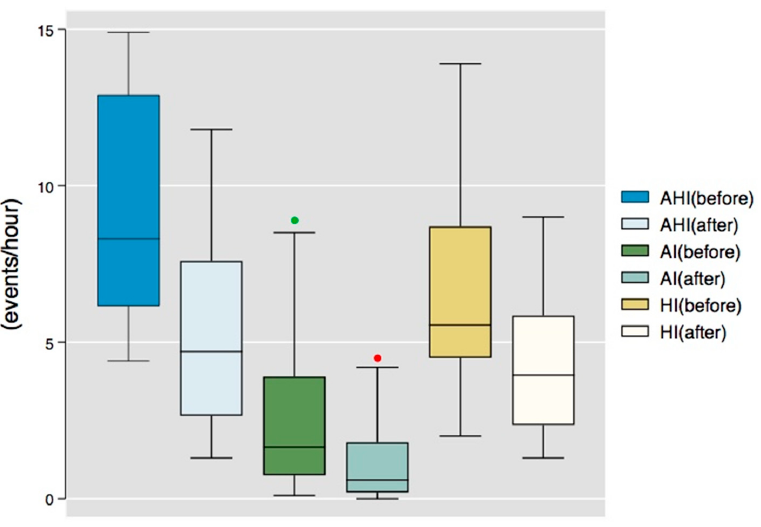
Figure 2. Box graph of apnea/hypopnea index (AHI), apnea index (AI), and hypopnea index (HI) before and after mouth-taping. (The green and red dots represent outliners of each parameter)